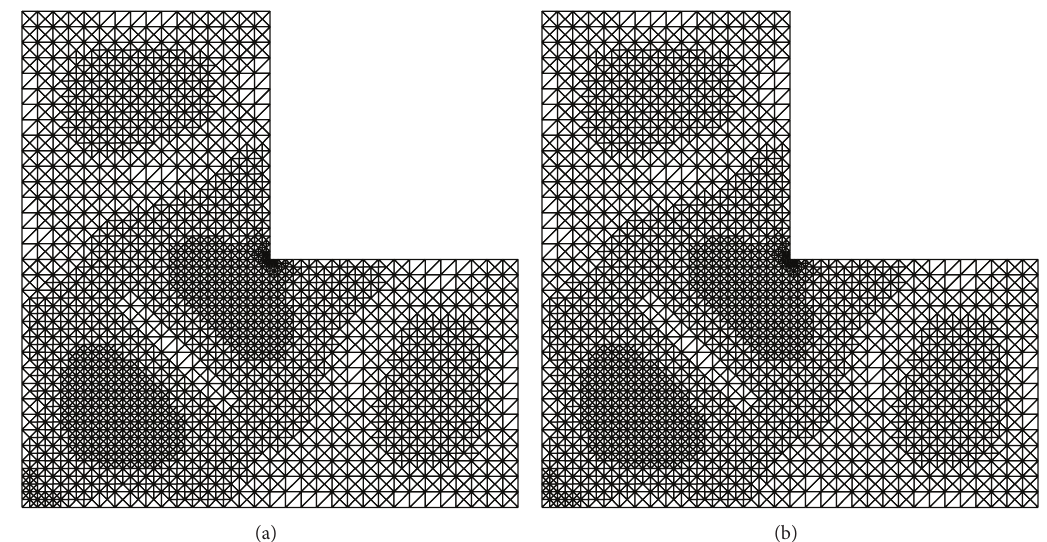
Figure 3: The adaptive meshes of 5th eigenvalue after 5th iteration by Algorithm 10 (a) and Algorithm 11 (b).